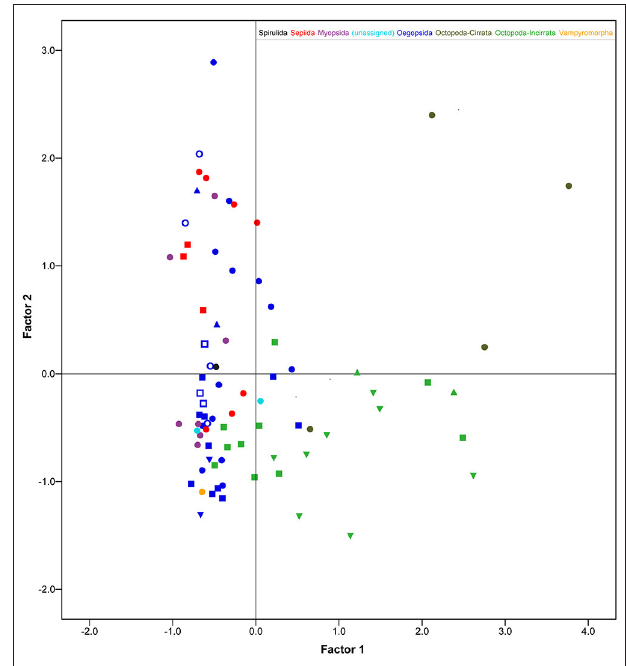
FIGURE 2 | Scatter plot of factor score values (after regression following PCA, Gorsuch, 1983) of the 78 cephalopod species belonging to the six Orders (color-coded) considered in this study. Different symbols group various taxa for a given order, whenever applicable (see Supplementary Information and Supplementary Table 4 for details). Cirrata and Incirrata are coded with different grades of green. Only the first two factor scores are considered here. See text for details and Table 3 for relative proportions of cephalopod brains between species allocated in different